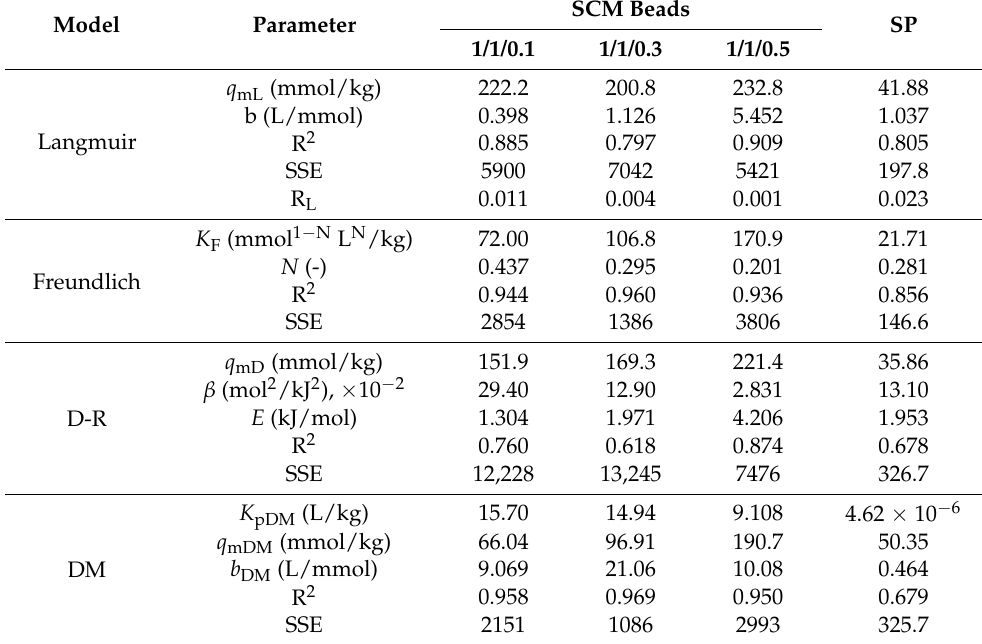
Table 5. Comparison of the isotherm model parameters for